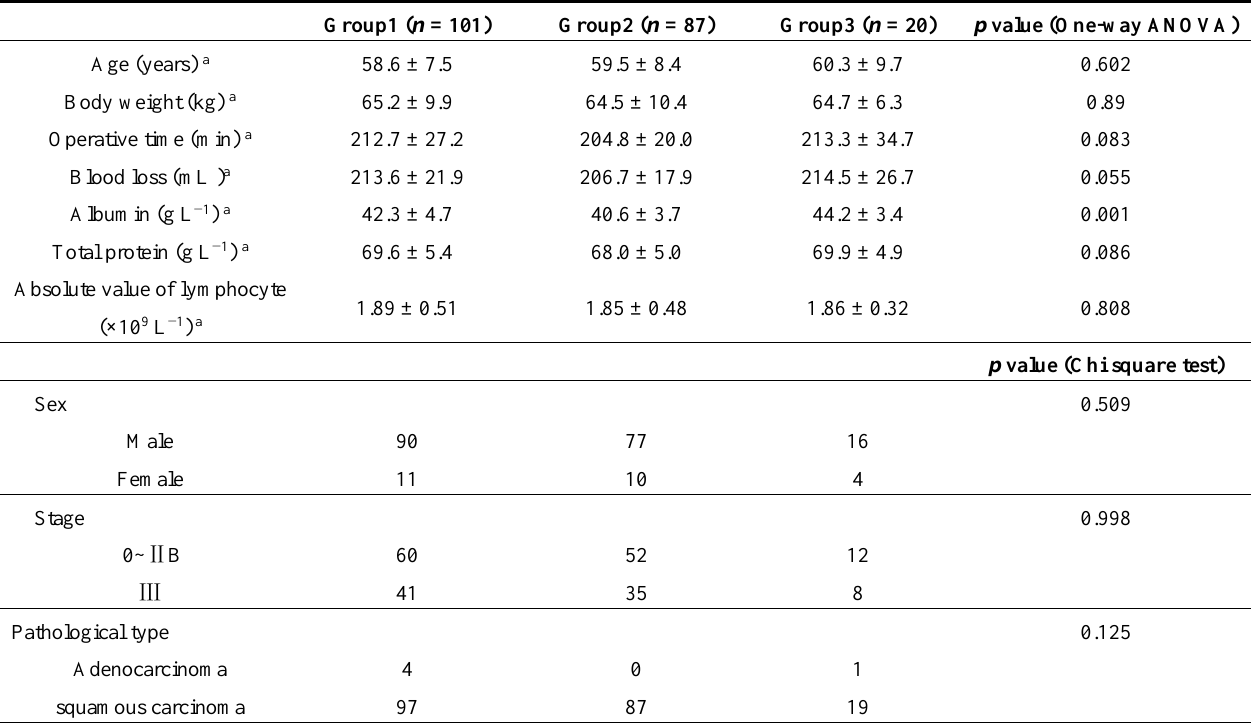
Table 1. Pre- and peri-operative clinical features among the three